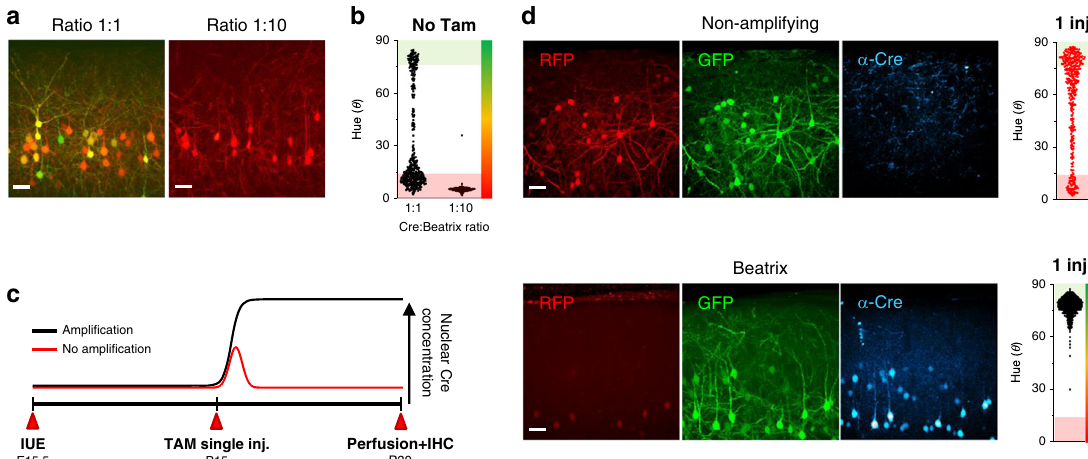
Fig. 3 Beatrix ampli fi es and preserves the transient activity of tamoxifen-inducible Cre. a Cortical neurons following in utero electroporation of ER T2 - Cre-ER T2 together with Beatrix in a 1:1 ratio, in absence of tamoxifen at P45. The leakage accumulated in the time interval between electroporation and imaging. This effect can be countered by lowering the concentration of the ER T2 -Cre-ER T2 plasmid to a 1:10 ratio. Scale bar 50 μ m. b Scatterplot showing the difference in hue distribution resulting from the leakage activity of ER T2 -Cre-ER T2 with Beatrix at the two different plasmid ratios. ( n = 3, n = 4 mice; n = 487, n = 315 cells). c Timeline of the experiment. ER T2 -Cre-ER T2 was electroporated in utero together with Beatrix or the non-amplifying reporter in a 1:10 ratio. At P15 we performed a single tamoxifen injection (100 μ g/g animal weight) that usually does not lead to complete recombination. d A single tamoxifen injection at P15 led to a transient Cre activation in most cells, but, as witnessed by the co-expression of GFP and RFP, the reporter was not fully recombined, thus proving an ambiguous reporting of the recombination state ( n = 3 mice, 408 cells). In presence of Beatrix, every cell responds to the transient Cre activation by triggering the self-ampli fi cation, thus leading to complete recombination and to the loss of the red fl uorescence ( n = 5 mice, 1040 cells). Cells with a high level of expression show some residual red fl uorescence localized in the nucleus because of the long halftime of DsRed2 protein in cells. The stabilization of the transient Cre activation was con fi rmed by immuno fl uorescence staining of Cre protein, attesting the presence of the enzyme in cell nuclei 15 days after tamoxifen induction. On the other side, no Cre-positive cells were found in animals electroporated with the inducible Cre and the non-amplifying reporter, indicating how the recombinase activity in this case is temporally con fi ned to the 24 – 36 h following the injection, thus leading to the massive presence of non-recombined or partially recombined cells. Scale bar 50 μ m. For each experiment, cumulative scatter plots of the polar angle values ( θ ) of each cell are reported on the